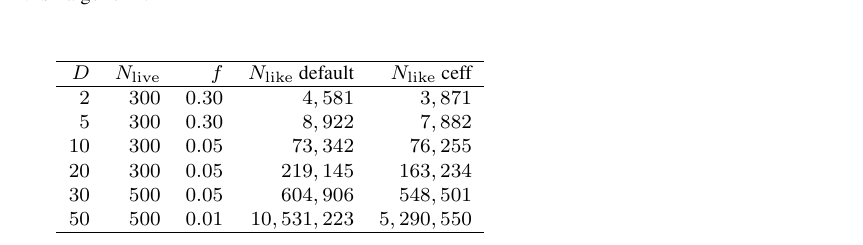
F IG . 3.— Test problem 1: (a) two-dimensional plot of the likelihood function defined in Eqs. (21) and (22); (b) dots denoting the points with the lowest likelihood at successive iterations of the M ULTI N EST algorithm.